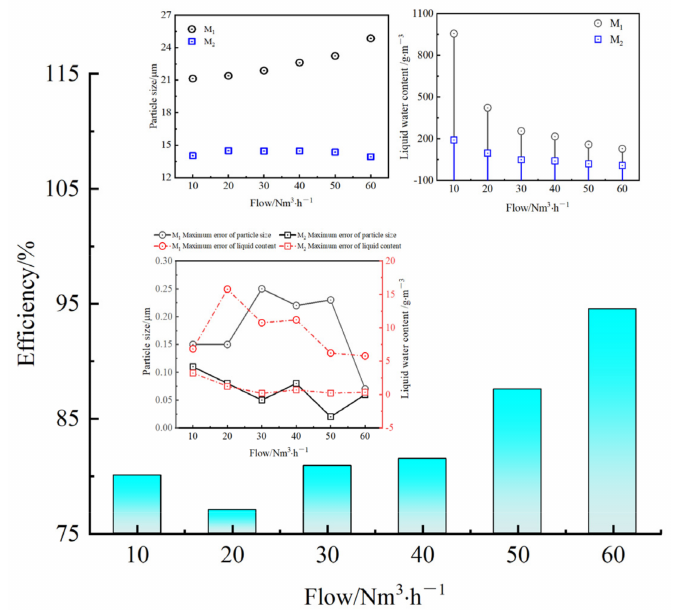
Figure 6. Comparison of liquid particle size and content in Case 1 at M 1